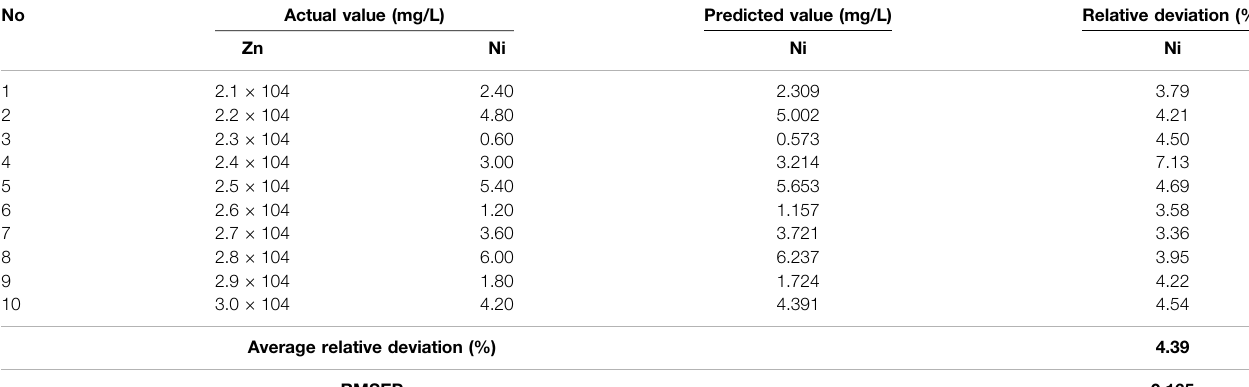
TABLE 1 | The predicted concentrations of Ni by EKF_Adaboost method. No